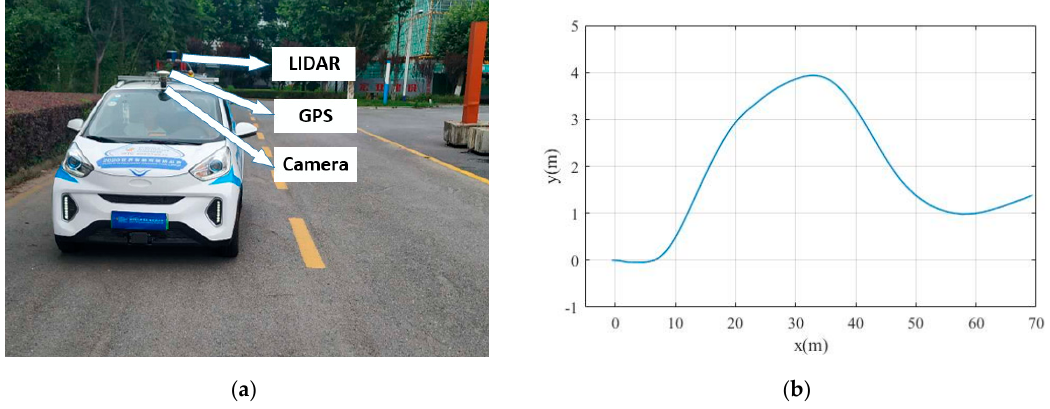
Figure 11. The experimental scene: ( a ) self-developed autonomous vehicle; and ( b ) trajectory of double lane changing obtained by GPS sensing system.